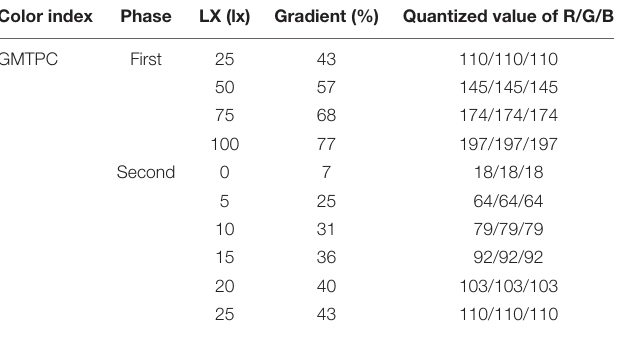
Photosensitivity Experiment of Larvae to Light Intensity.” Then, the display was turned on and the larvae were sampled after 60- minute lighting. All larvae were distinguished and counted under a